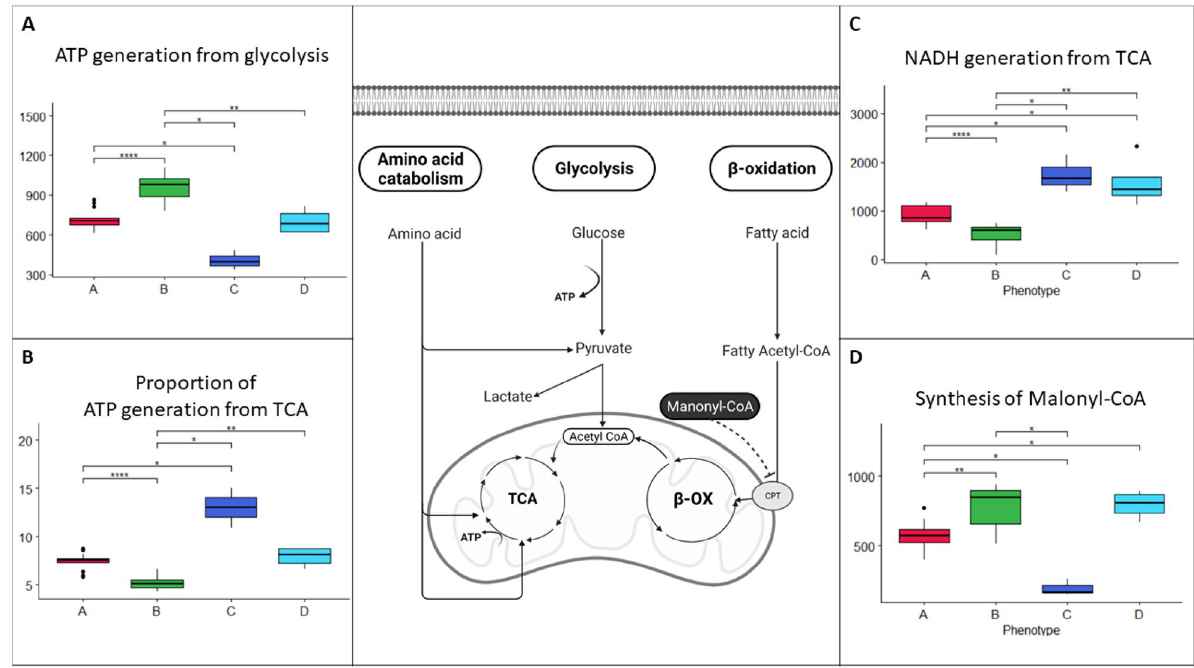
Figure 3. Metabolic cellular activities in phenotypes ( A – D ) . ( A ) ATP generation from glycolysis in the four PH phenotypes. ( B ) Proportion of ATP generation from TCA (overall ATP generation from glycolysis and TCA/ATP generation from glycolysis) in the four PH phenotypes. ( C ) NADH generation by TCA in the four PH phenotypes. ( D ) Synthesis of malonyl-CoA in the four phenotypes. The cellular overview was created with